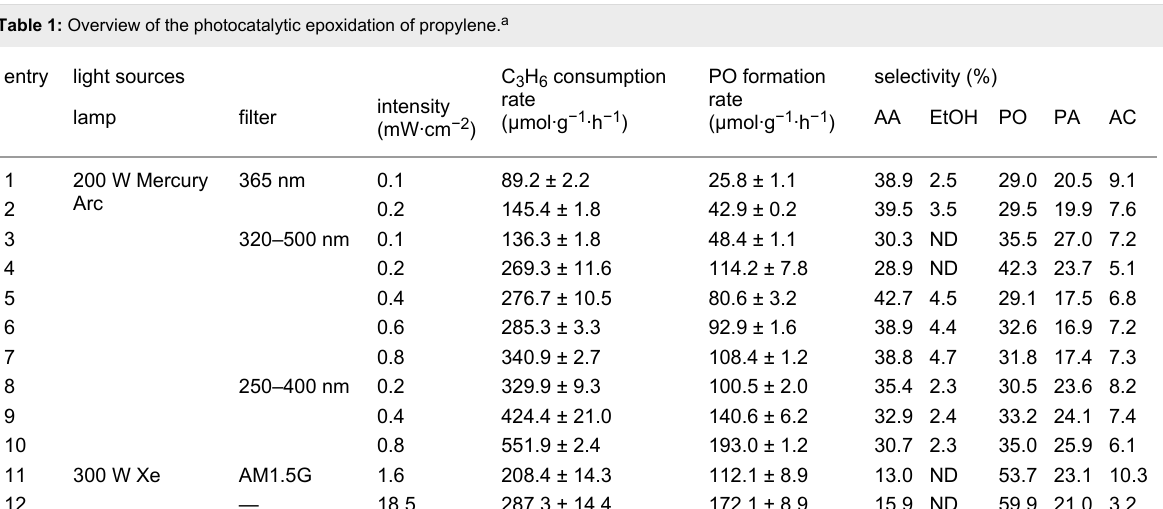
Table 1: Overview of the photocatalytic epoxidation of propylene. a